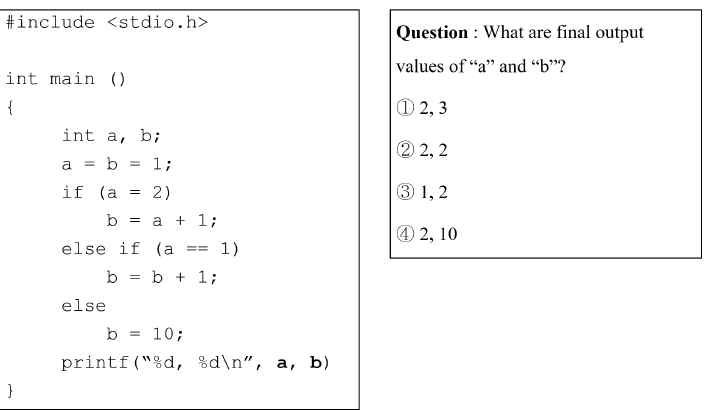
Figure 6. Example of the problem assigned to a student in this experiment (from https://www.gosi. kr/). Question: Find an answer that shows the final output of this source code (since the question is in Korean, we have translated it to English).